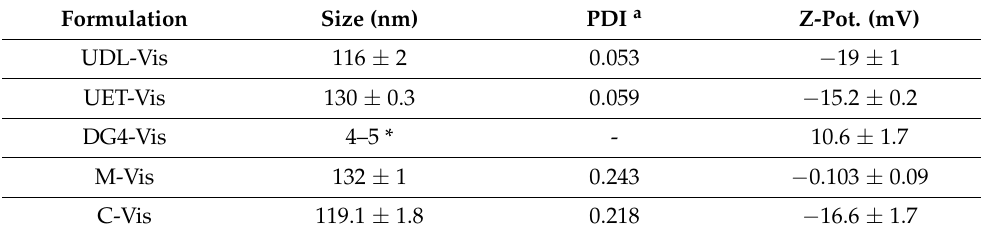
Table 1. Size and Z-Potential of Vismodegib-Loaded